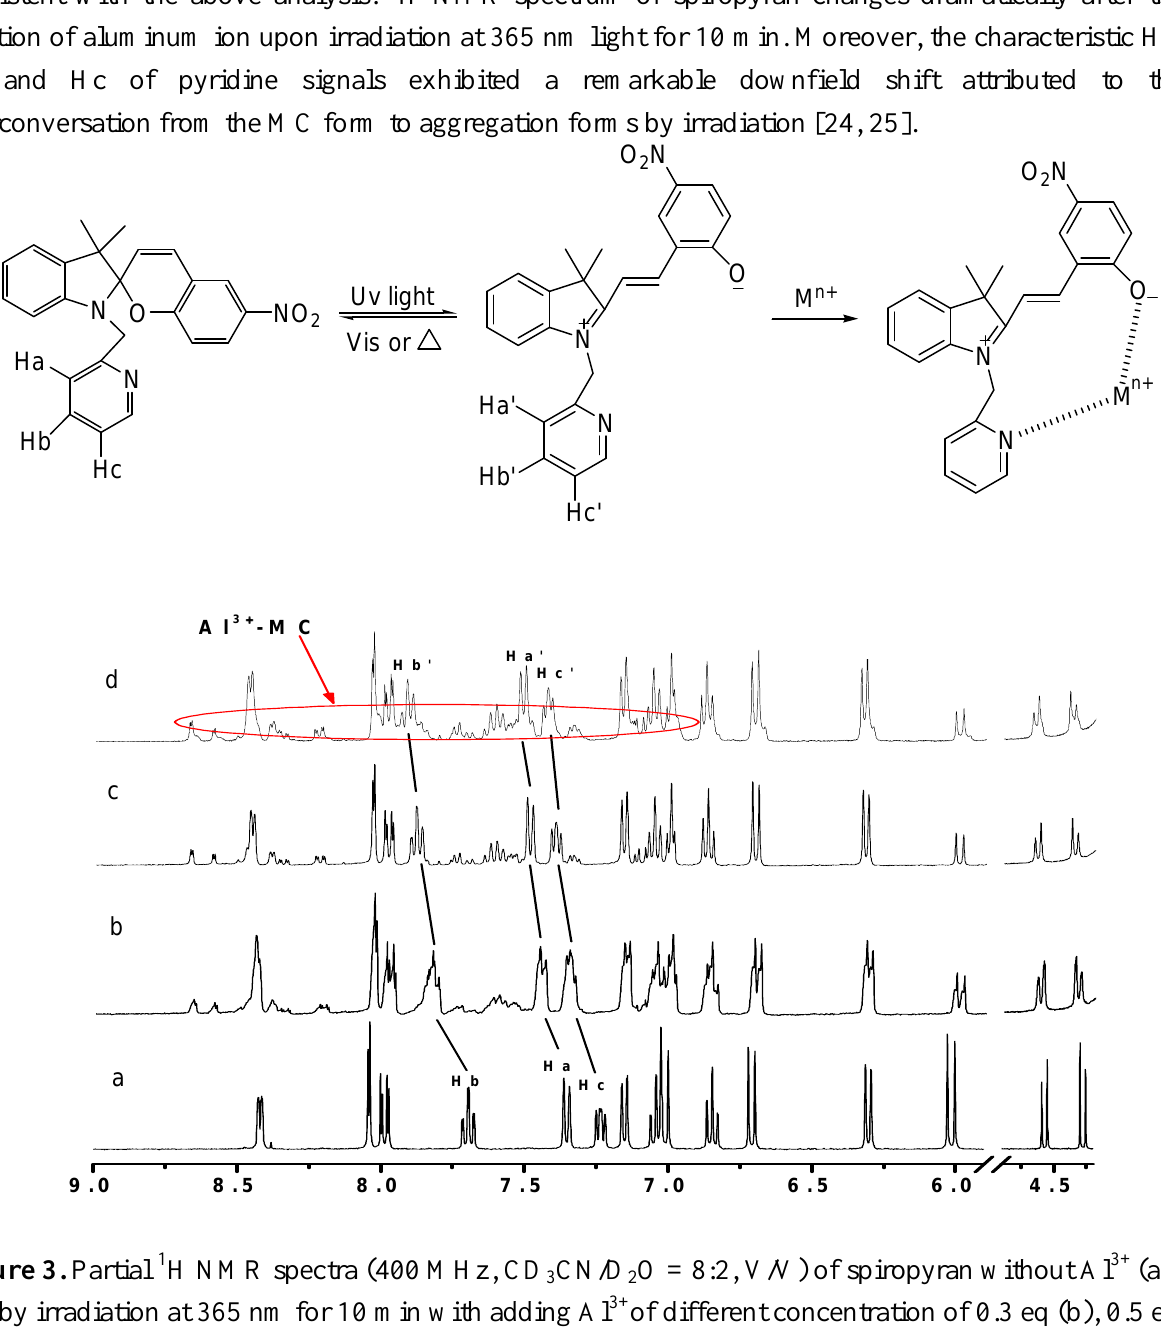
Figure 3. Partial 1 H NMR spectra (400 MHz, CD and by irradiation at 365 nm for 10 min with adding Al 3+ of different concentration of 0.3 eq (b), 0.5 eq